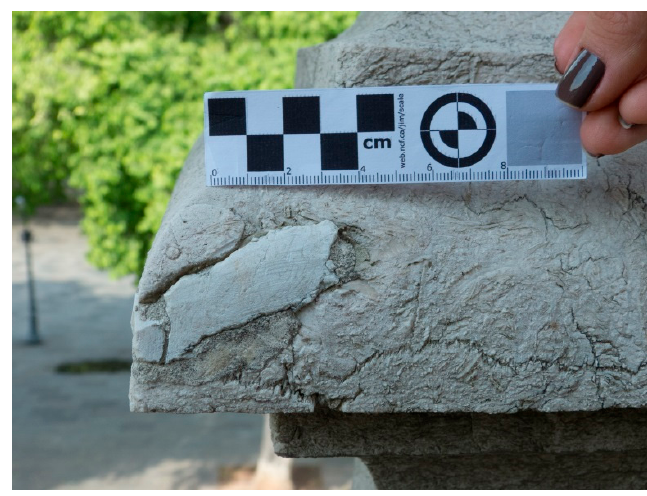
Figure 9. Lioz limestone area with restored part.